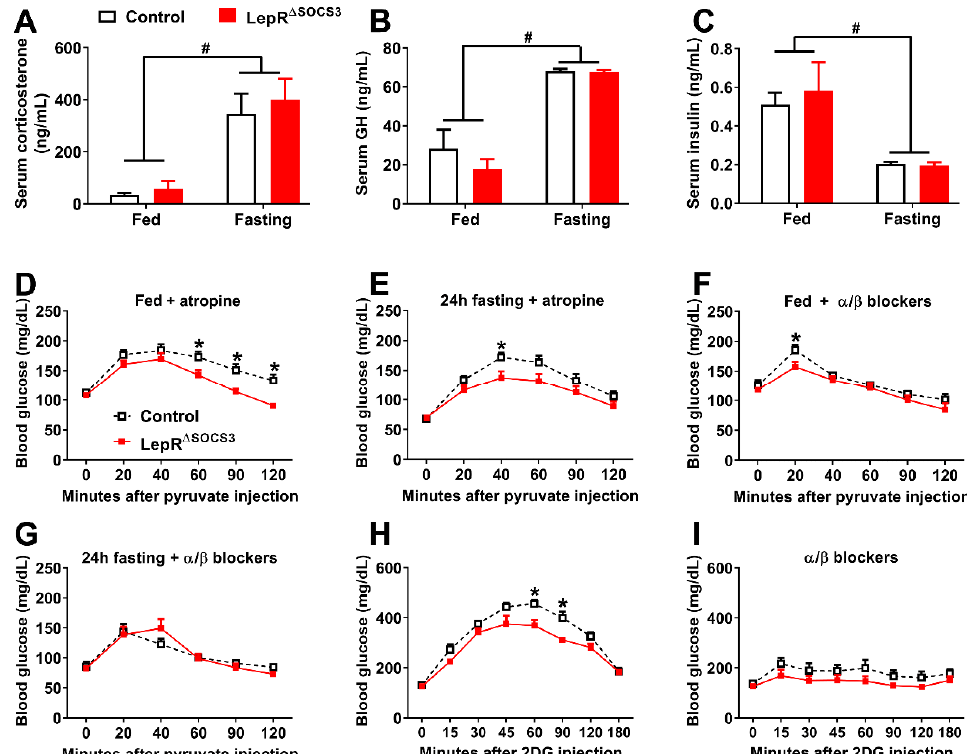
Figure 10. Possible alterations in the sympathetic nervous system explain the impaired gluconeo- genesis and counterregulatory response of LepR ∆ SOCS3 mice. ( A – C ) Serum corticosterone, GH and insulin concentrations in the fed state or after 24 h fasting in young adult control ( n = 5–8) and LepR ∆ SOCS3 ( n = 4–8) mice. ( D – G ) Blood glucose levels during pyruvate tolerance tests in young adult control ( n = 6–14) and LepR ∆ SOCS3 ( n = 5–13) mice at the fed state or during 24 h fasting in combination with the co-infusion of atropine ( D , E ) or α / β blockers ( F , G ). ( H , I ) Blood glucose levels show the counterregulatory response induced by 2DG injection in young adult control ( n = 7–9) and LepR ∆ SOCS3 ( n = 7–9) mice. Mean ± SEM. # p < 0.05 fasting effect (two-way ANOVA). * p < 0.05 control vs. LepR ∆ SOCS3 (post-hoc test repeated measures two-way